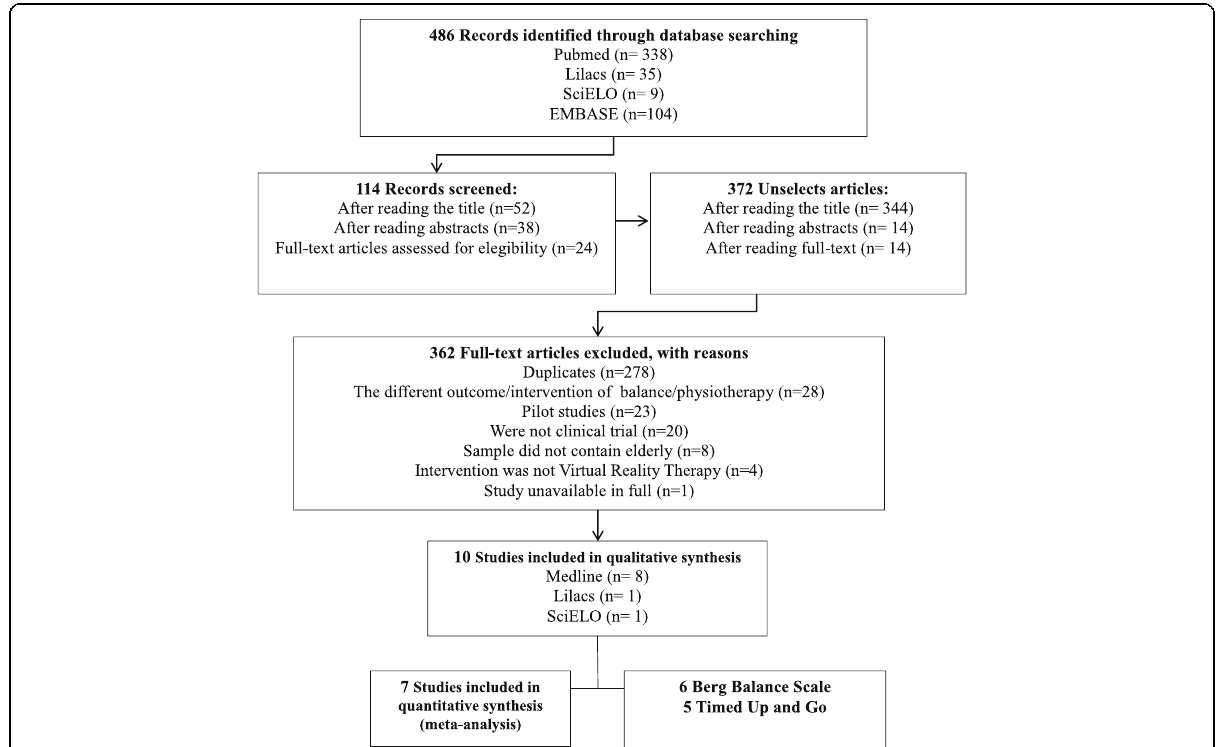
Fig. 1 Preferred Reporting Items for Systematic Reviews flow diagram of the studies included in our